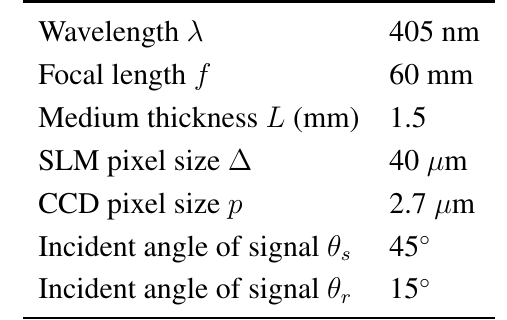
Table 1. Experimental